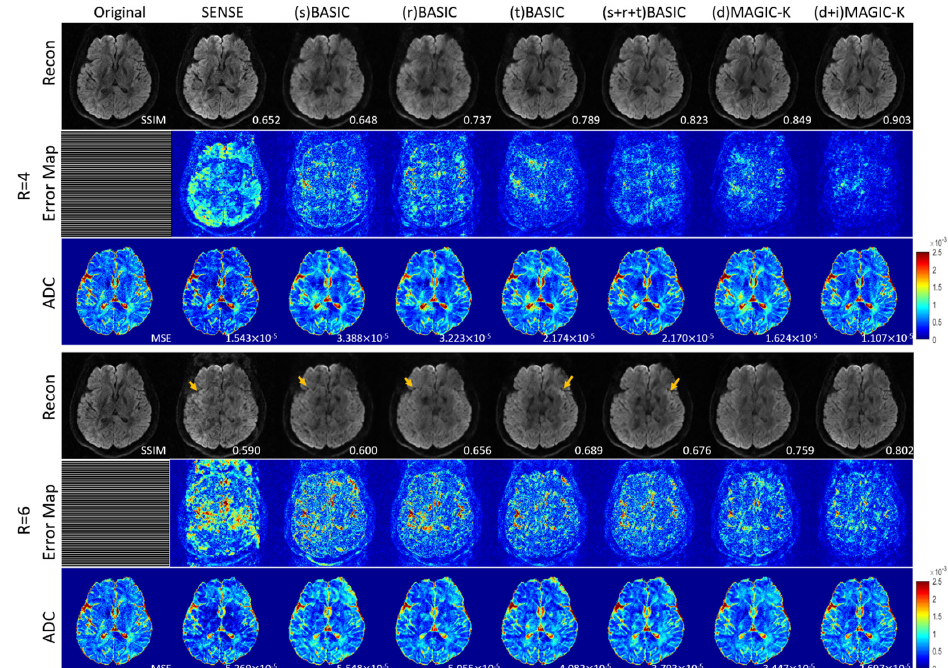
Figure 3. Comparison of the reconstructed images by different image augmentation strategies using uniform undersampling in a healthy volunteer. The SSIM is listed at the bottom-right of each reconstructed image. The error map was × 10 amplified for better visualization. The MSE is listed at the bottom-right of each ADC map. The aliasing artifacts are depicted by the yellow arrows.